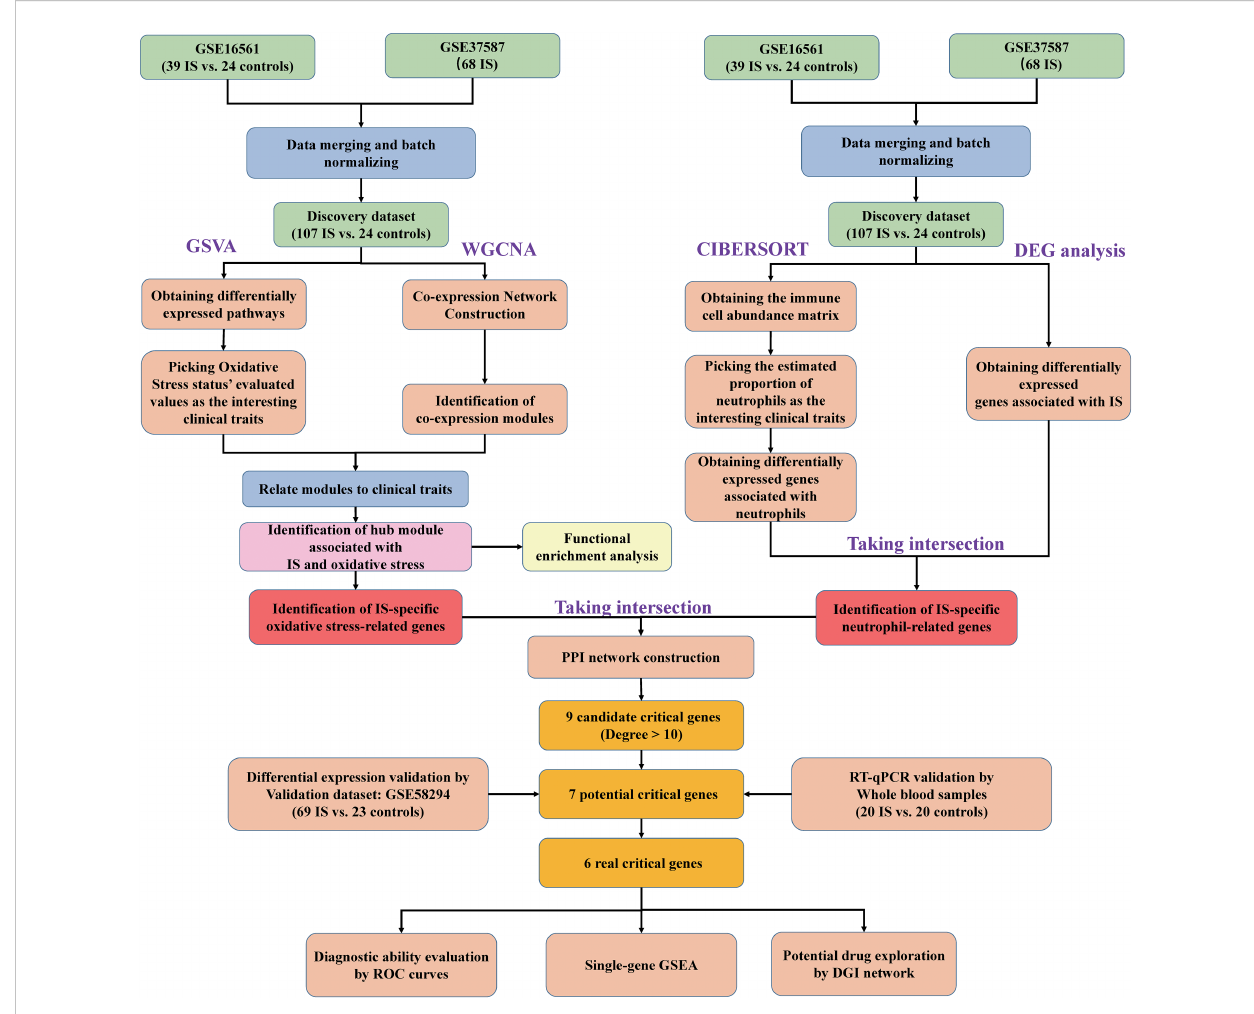
FIGURE 1 Flow chart of the transcriptomic bioinformatics analysis for early ischemic